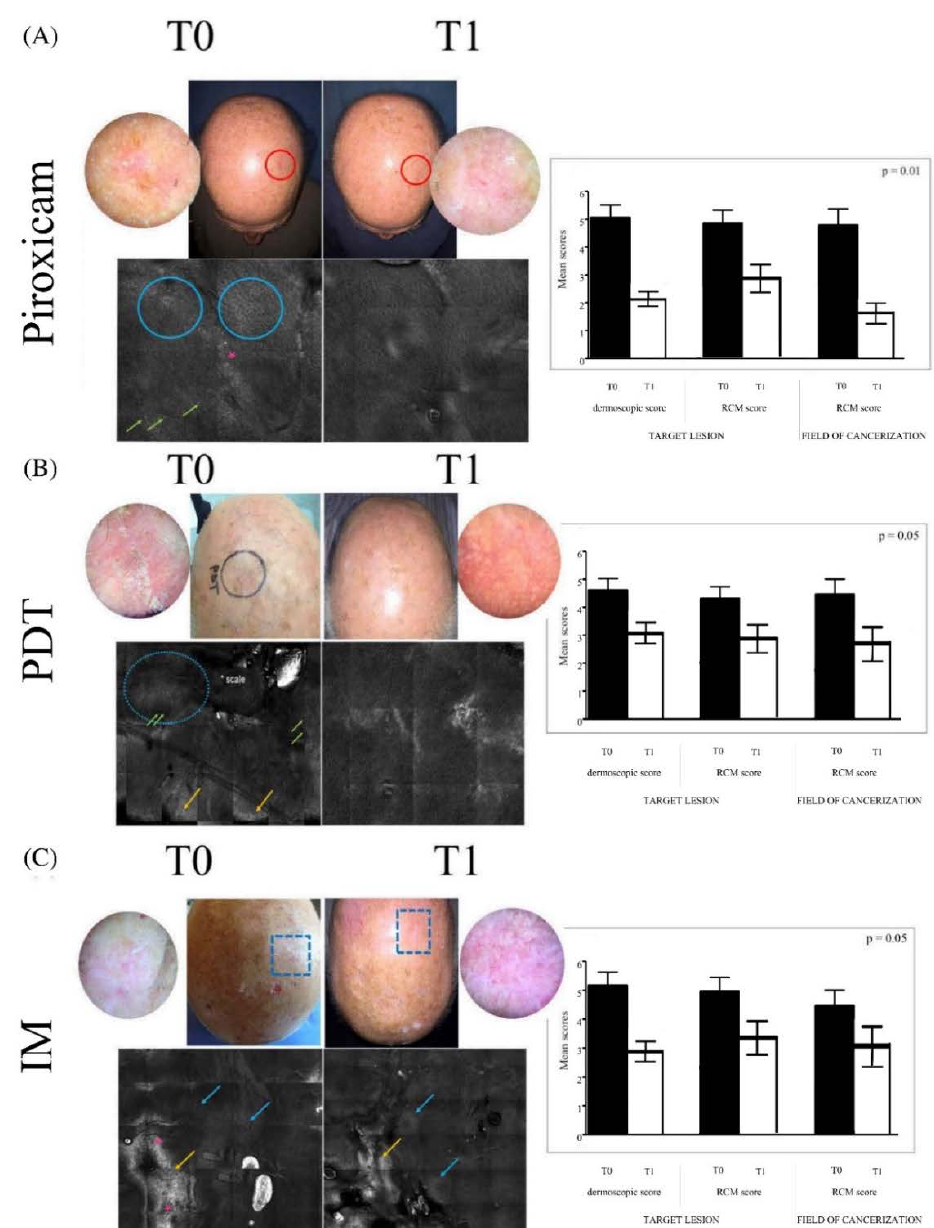
Figure 1. Clinical, dermoscopic, and reflectance confocal microscopy evaluation before (T0) and after treatment (T1). In the panels on the left, the images represent the clinical aspects of the target lesion and the field of cancerization of the scalps of different patients treated with different therapies: ( A ) medical device 0.8% piroxicam and 50+ sunscreen, ( B ) photodynamic therapy (PDT), ( C ) 0.015% ingenol mebutate (IM) gel; the dermoscopic features of the target lesion, in detail; and reflectance confocal microscopy mosaic (6 × 6) aspects of the target lesion and the field of cancerization. The blue circles and arrows indicate the atypical honeycombing pattern, constituted by pleomorphic keratinocytes; the red asterisks areas of detached keratinocytes; the green arrows inflammatory infiltrate; and the yellow arrows hyper- and para-keratosis. In the panels on the right, we report the dermoscopic and reflectance confocal microscopy scores of the target lesion and the reflectance confocal microscopy scores of the field of cancerization for the respective treatments.